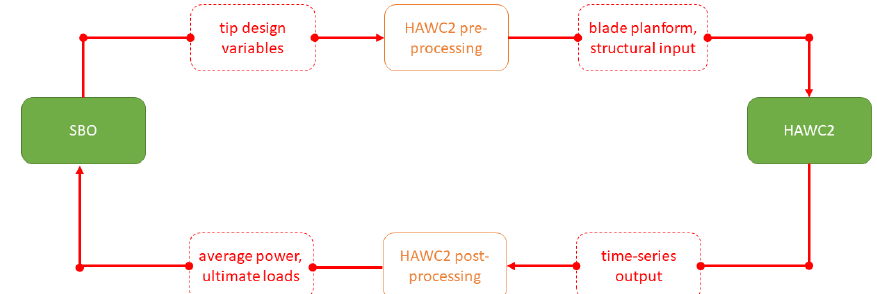
Figure 4. SBO setup top-level